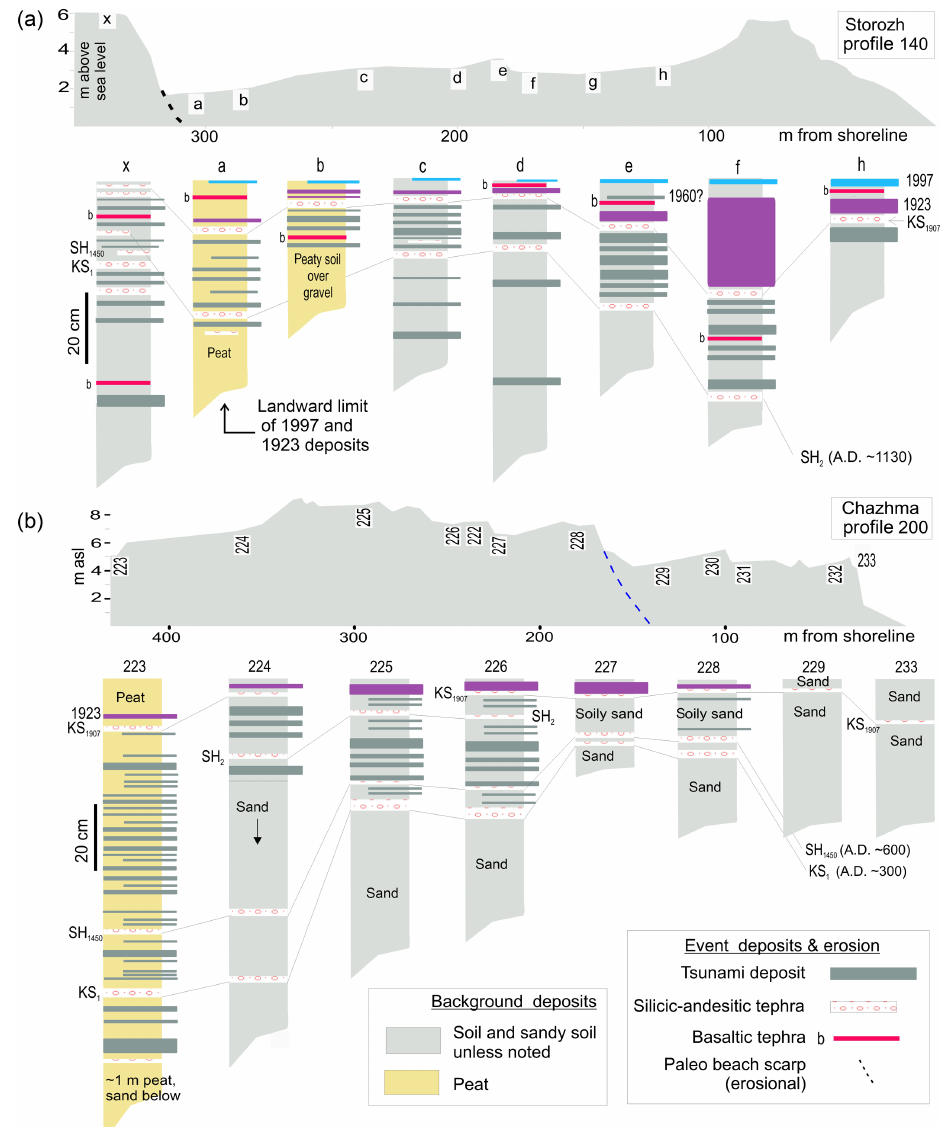
Figure 9. Example of two profiles that illustrate paleotsunami deposits used in analyses. Also see Figs. 4, 7, 8; tephra and tsunami deposits that are shown as narrower bands, e.g., 1997 in excavation 268, indicate thin, patchy deposits. Storozh profile 140 (a) : here we use this profile to illustrate an analysis of tsunami deposits between KS 1907 and SH 2 ; note that the deposits thin landward, in general. In most excavations there are six tsunami deposits between KS 1907 and SH 2 ; excavation “x” has only three. Thus all six tsunamis reached “a” but only three reached “x” or three of the six tsunamis only reached “a”. All six tsunamis had to exceed the height of the shoreward beach ridge at the time of deposition. Chazhma profile 200 (b) : as in profile 110 (Fig. 8), this profile has undergone uplift through time. For sub-SH 2 deposits, the profile was reconstructed to 4m lower and 150m narrower. Sites 229–233 are young; the profile from 228 landward is older than KS 1 ( ∼ AD300). Site 223 is not far from the modern Chazhma River and in the past some tsunamis may have flooded this site via the river, when the profile was lower. Sites 226 and 225 both have six deposits between SH 2 and SH 1450 ; no other excavation on this profile provides a good count in this interval, but these six deposits probably are in the record at 223, and 224 was simply too sandy (lacking soil separation between layers) to count all layers in this interval. SH 2 is not preserved (was not detected) in the peat excavation (223), but the 23 tsunami deposits in this excavation can be used in the overall count above KS 1 . Excavations 223, 225, and 226 all preserve tsunami deposits between SH 1450 and KS 1 . In this interval the peat excavation (223) contains six deposits to the two in 225 and 226, for two possible reasons; first, peat is a better preserver/displayer of thin layers, and second, 223 is lower than 225 and 226, and at this time all were closer to shore. For the latter reason, 223 may have received tsunamis and their deposits directly from the river rather than over the beach ridge(s).